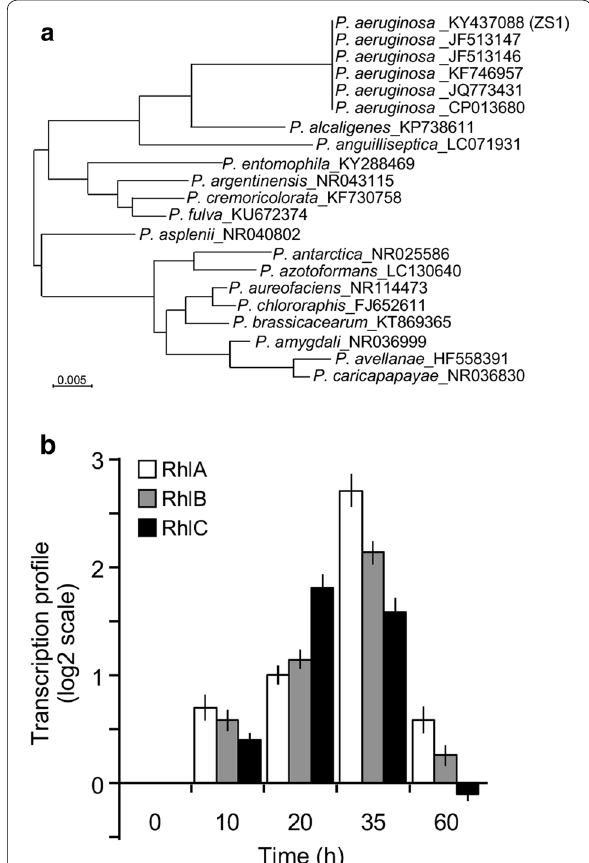
Fig. 2 Biosurfactant-producing ZS1 isolate belongs to the group of Pseudomonas aeruginosa . a The 16S rDNA sequence-based phylogenic analysis of the ZS1 isolate. The isolate is indicated as ZS1 in parentheses , whose nucleotide sequence is available in Genebank (https://www.ncbi.nlm.nih.gov/genbank) with the Accession Number KF668476). b Transcription of rhamnolipid synthesis genes is induced in medium with glucose as sole carbon source. qRT-PCR analysis of RhlA, RhlB, and RhlC gene expression at various time-points after ZS1 growth in MS medium supplemented with